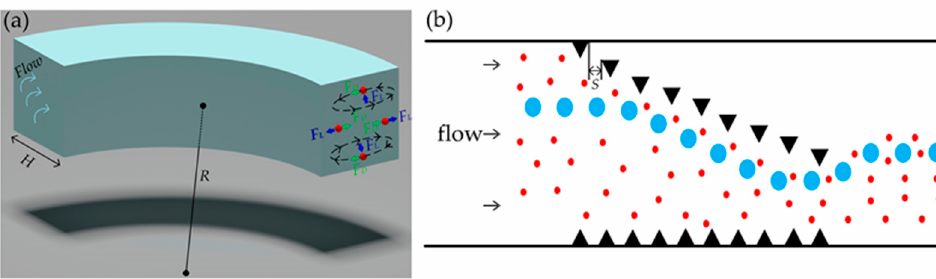
Figure 2. ( a ) The secondary flow in the curved channel forms two symmetrical vortices in which the particles are subjected to inertial lift F L and Dean drag F D ; ( b ) The particles are deflected upward due to the sudden disappearance of the end pillar of the micropillar array.